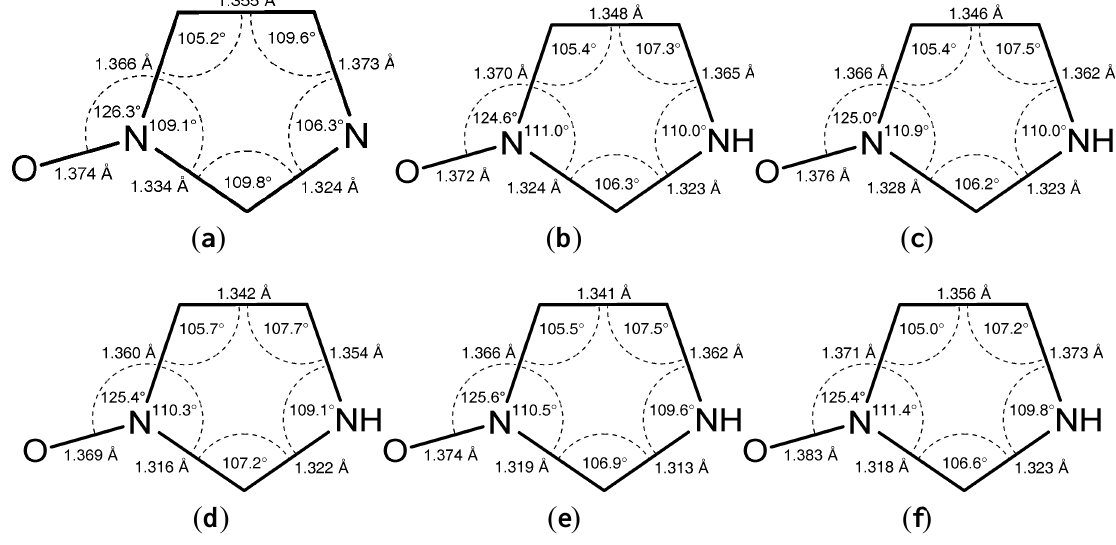
Figure 1. Bond lengths and angles in the heterocyclic system of ( a ) 1-hydroxyimidazole; ( b ) 1-hydroxyimidazole hydrochloride; ( c ) 1-hydroxyimidazole hydrobromide; ( d ) and